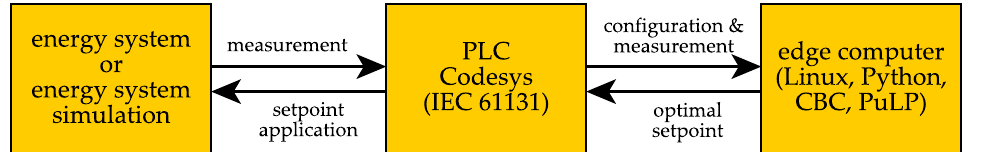
Figure 2. Block diagram of the control system structure: measurements of the energy system (or a digital twin energy system simulation) are taken by the PLC (Wago PFC200 [19]) and are forwarded to the edge computer (Wago Edge Computer [20]) together with configuration data from commissioning. In the edge computer, the system model is composed, and optimal setpoints are calculated, which are then applied to the energy system by the